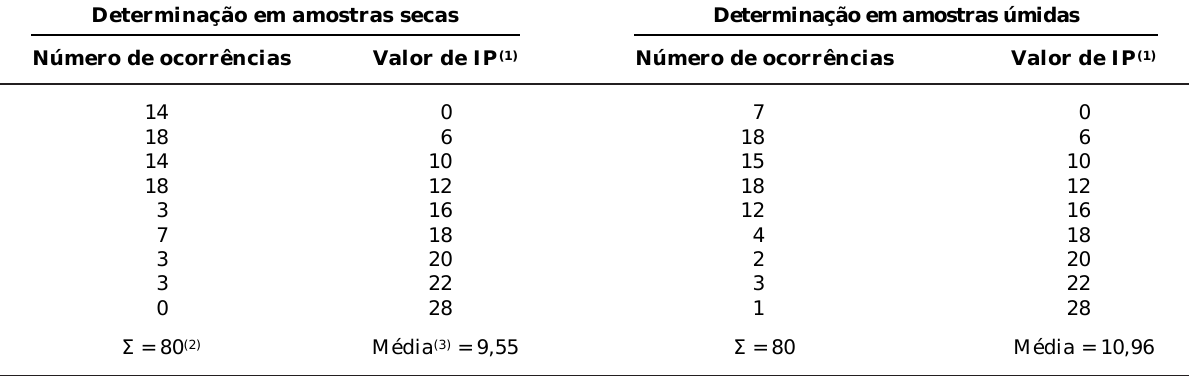
(Figura 1a). O valor entre as siglas foi exatamente o valor que quantifica quantos pontos, em média, na escala ordenada, uma determinação super (sinal positivo) ou subestimou (sinal negativo) a outra. Por exemplo, na prática, significa dizer que, quando P2 e P5 foram comparados, na determinação do matiz das 80 amostras úmidas, P2 apresentou uma tendência em superestimar o valor determinado por P5 em 0,59259